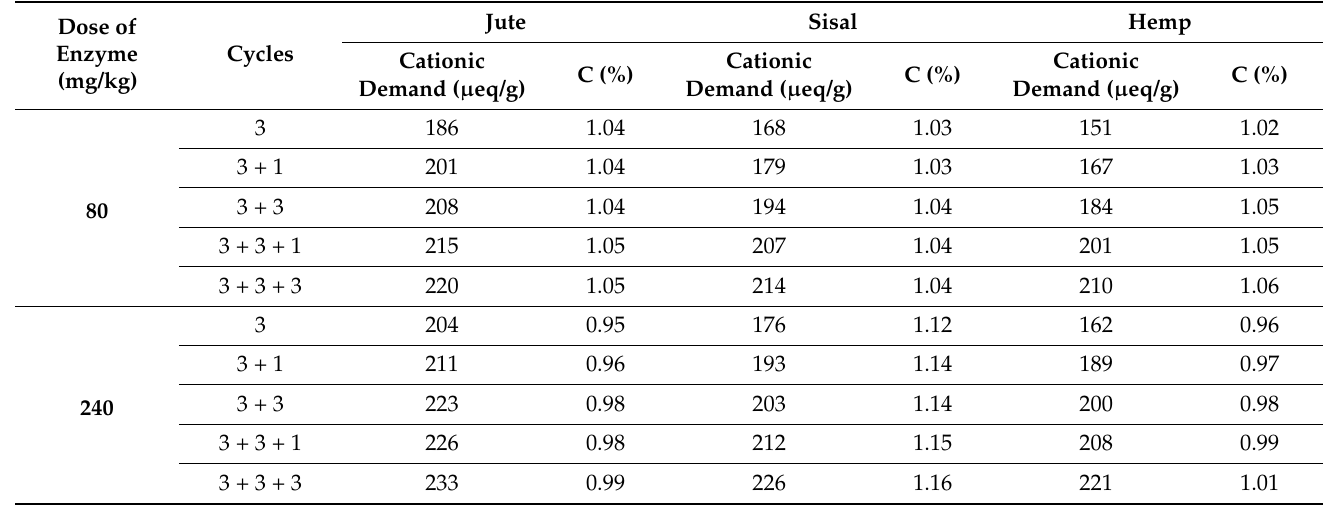
Table A3. Consistency (C) and cationic demand of all enzymatical MNFC samples. There were no significant variations in the carboxyl content.